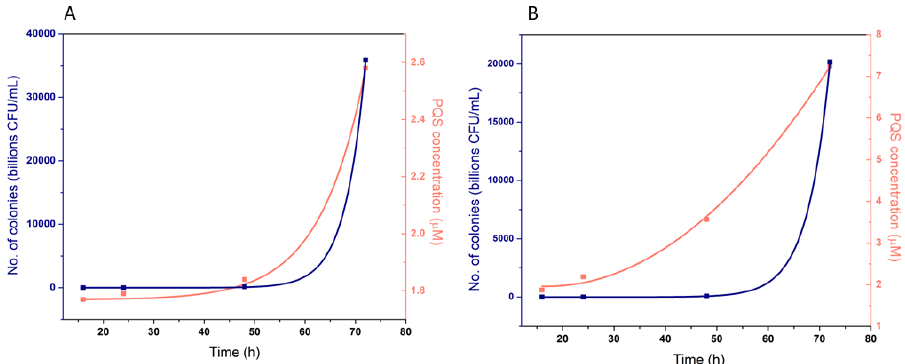
Figure 11. Correlation between the concentration of PQS, determined with the sensor and the number of bacterial cells of P. aeruginosa ( A ) ATCC 27853 strain and ( B ) clinical isolate. The number of bacterial cells ( blue , left O-Y axis) and the concentration of PQS determined with the sensor ( orange , right O-Y axis) as a function of time (h) .